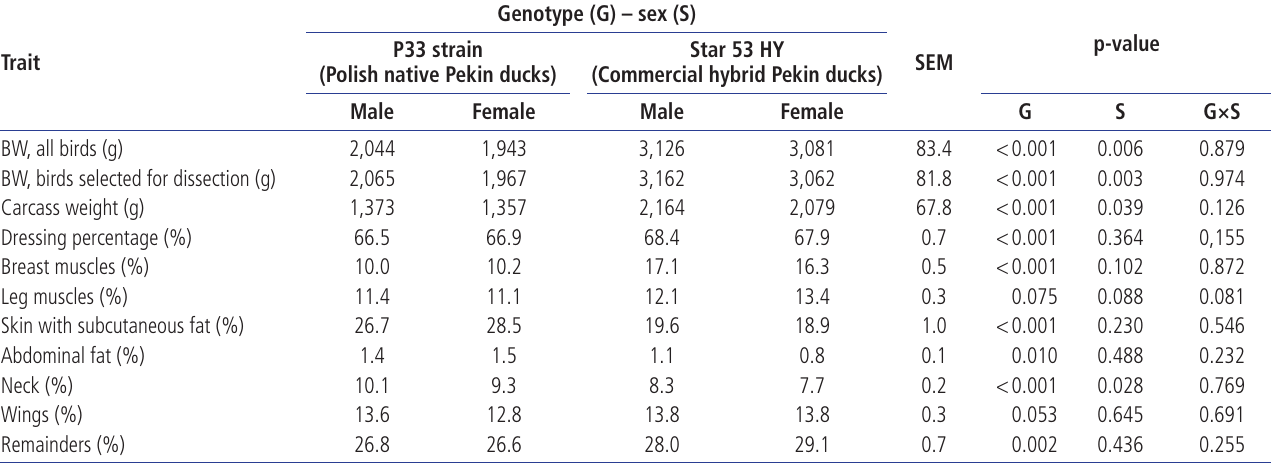
Table 3. Body weight and carcass characteristics of 49-d-old Pekin ducks of different genotypes